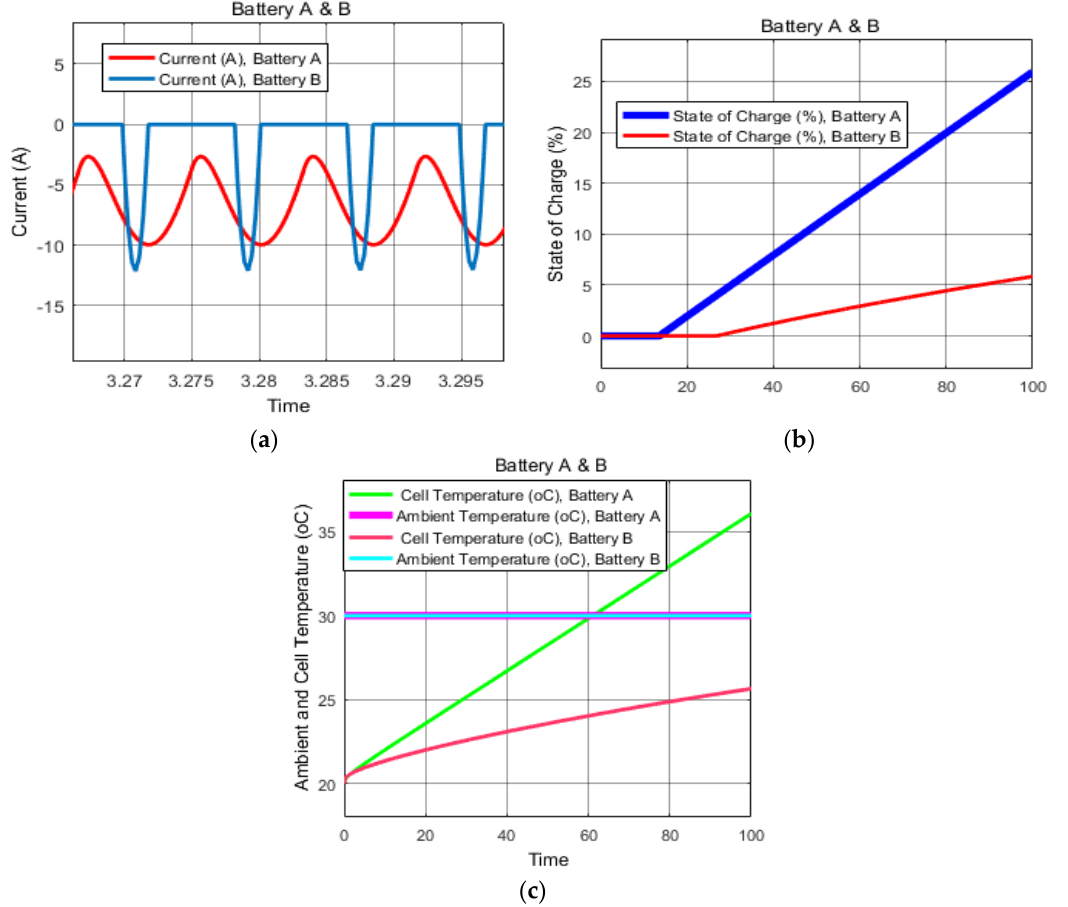
Figure 4. Results of VMC applied to Li-ion battery A. The charging current ( a ) is under safe limits of 10 A, and state of charge ( b ) of battery A is 26 %, while that of battery B is 6%. ( c ) shows the temperature increase of 36 ◦ C with